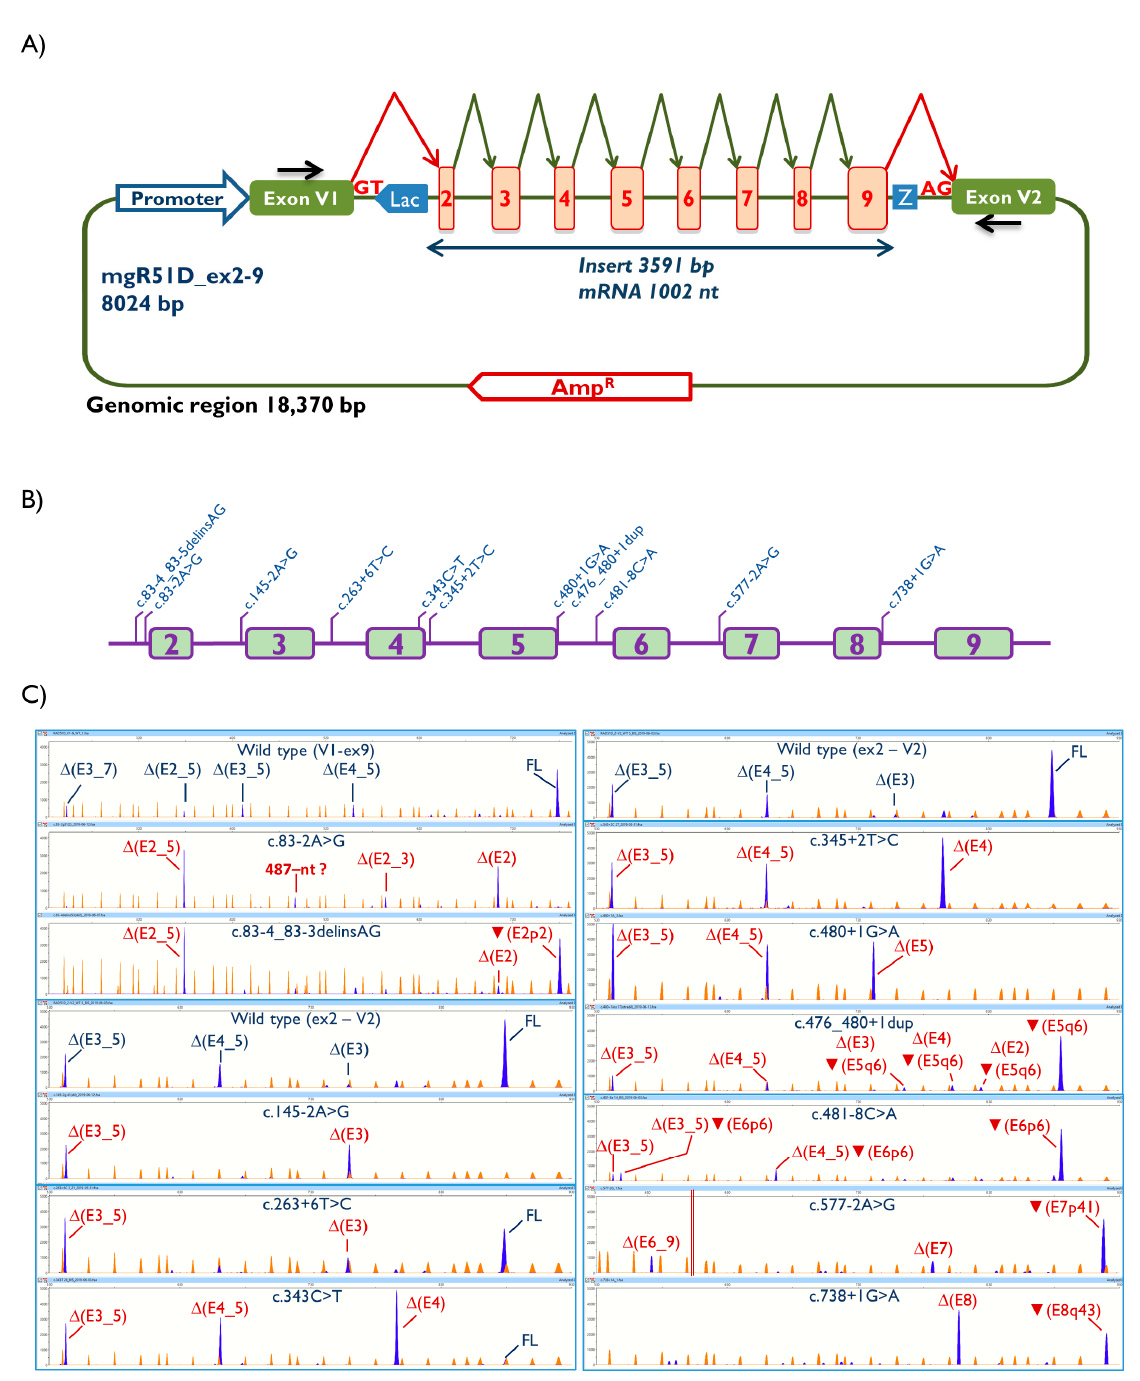
Figure 1. Structure of the minigene mgR51D_ex2-9 and functional assays of splice-site RAD51D variants. ( A ) Schematic representation of the RAD51D minigene, with exons 2 to 9. ( B ) Map of variants. ( C ) Fluorescent fragment analysis of transcripts generated by the wild type and mutant minigenes. FAM-labeled products (blue peaks) were run with LIZ-1200 (orange peaks) as size standard. FL: full-length transcript.